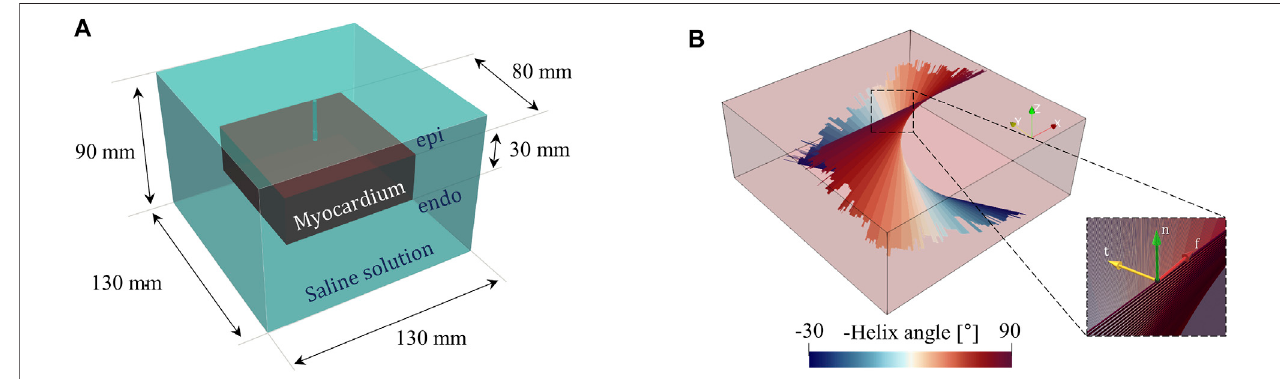
FIGURE 2 | (A) Computational geometry, including the myocardium and saline solution domain. (B) 3D fi ber distribution showing myocardium rotational anisotropy. The inset provides the fi bers local reference system with a right-handed orthonormal set of basis vectors ( f , t , n ), where f denotes the muscle fi ber axis, t the sheet (or cross – fi ber) axis, and n the sheet – normal axis n = f × t .